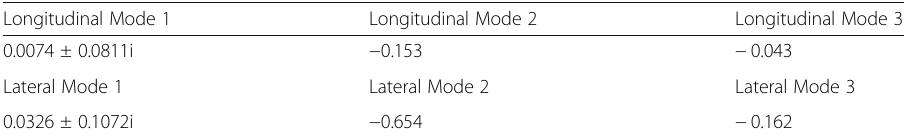
Table 7 Eigenvalues of system matrix